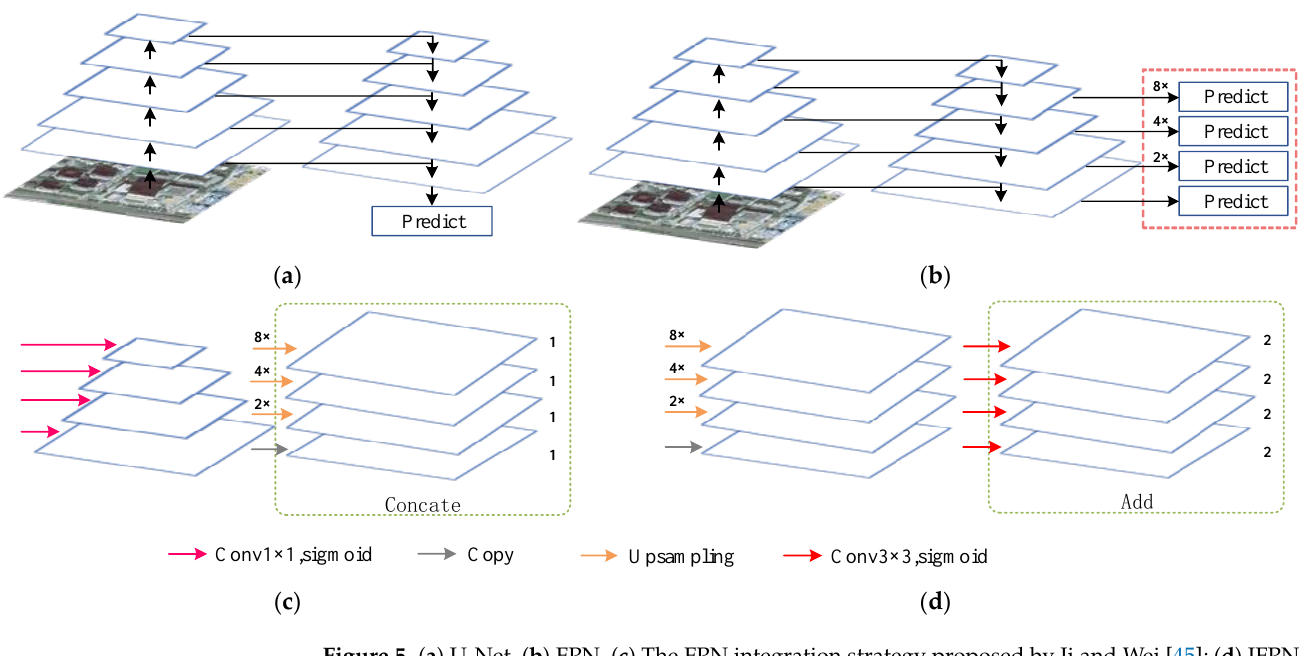
Figure 5. ( a ) U-Net, ( b ) FPN, ( c ) The FPN integration strategy proposed by Ji and Wei [45]; ( d ) IFPN.